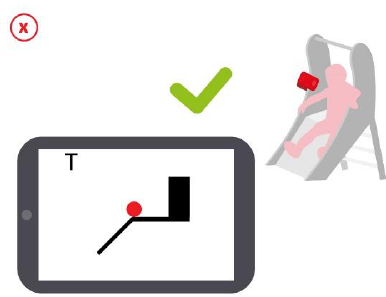
Figure 14. Schematic of the interaction produced by placing the sensor on the slide. The system detects that the child is waiting for jumping.